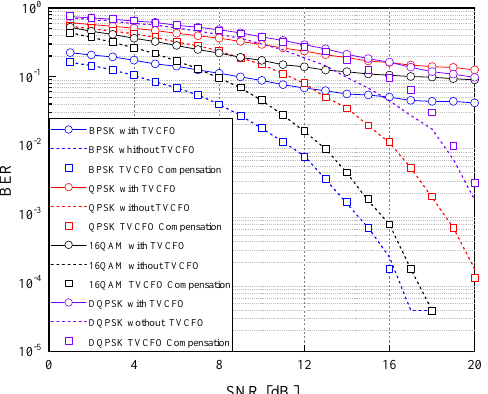
Figure 8. Bit error rate statistics of demodulation results in four cases: BPSK (blue), QPSK (red), DQPSK (purple), and 16QAM